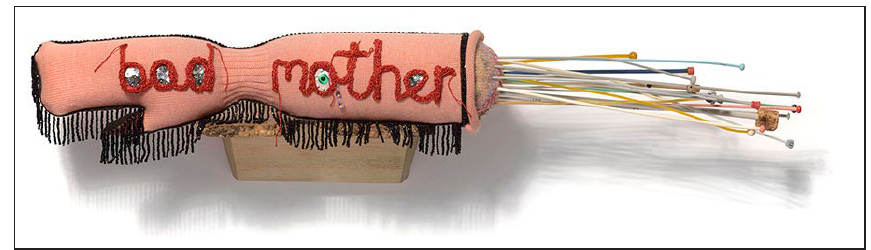
Figure 4: Bad Mother , 2013, machine knitted wool, machine knitted lurex, expanding foam, broken knitting needles, glass beads, sequins, dress pins, crystal beads on an oak and maple wood shelf, 780 × 160 × 160 mm. Photograph: Douglas Atfield.